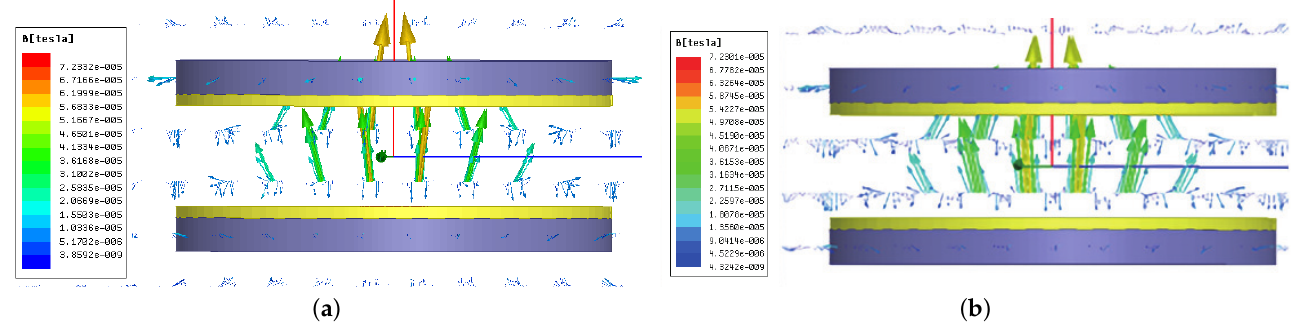
Figure 9. Comparison of two magnetic coupling structures’ magnetic line of force: ( a ) Magnetic line of force of planar core; ( b ) Magnetic line of force of the proposed